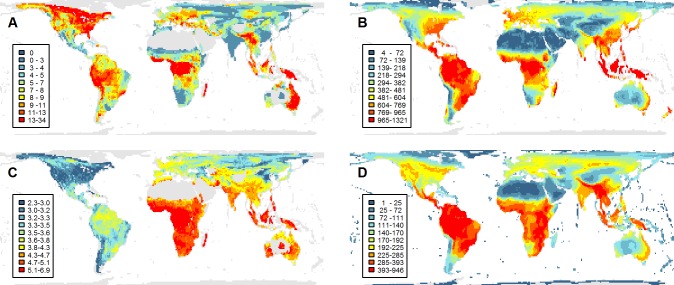
Observed geographic variation in (A) the incidence of coexistence of sister species (n = 1,021 pairs), (B) energy availability measured as net primary productivity (NPP; g C m-2 yr-1), (C) the median age of sister species (million years [Ma]), and (D) the total assemblage richness of all birds (n = 9,993). In (A), colours denote the percent of pairs within a quadrat that coexist locally (i.e., both present within that quadrat). Analysis grain size is 110 km, colours follow quantile classification (i.e., equal number of cells in each class), and, in (A,C), only quadrats containing at least 20 sister pairs are plotted. See Dryad depository for cell values [52].